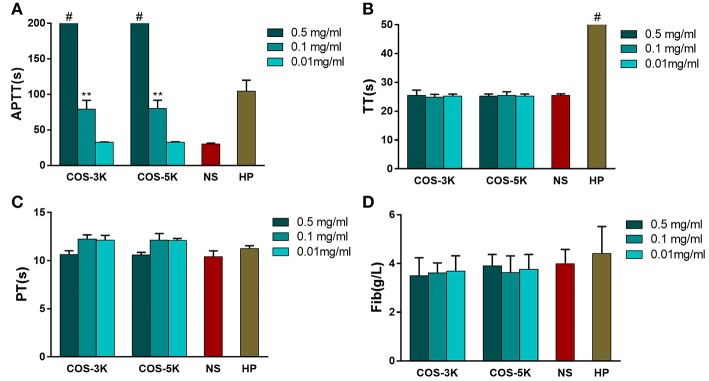
Analysis of influence on coagulation caused by COSs. (A) APTT of COSs and heparin. (B) TT of COSs and heparin. (C) PT of COSs and heparin. (D) Concentration of Fib. **p < 0.01 vs. NS group; # means the parameter exceeded machine available. NS, normal saline; HP, heparin.